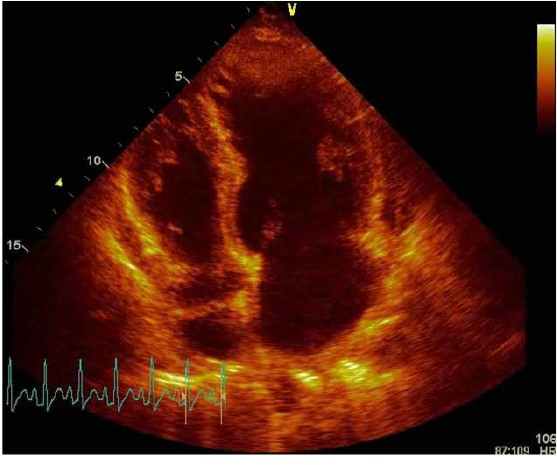
Figure 4. First echocardiographic examination.